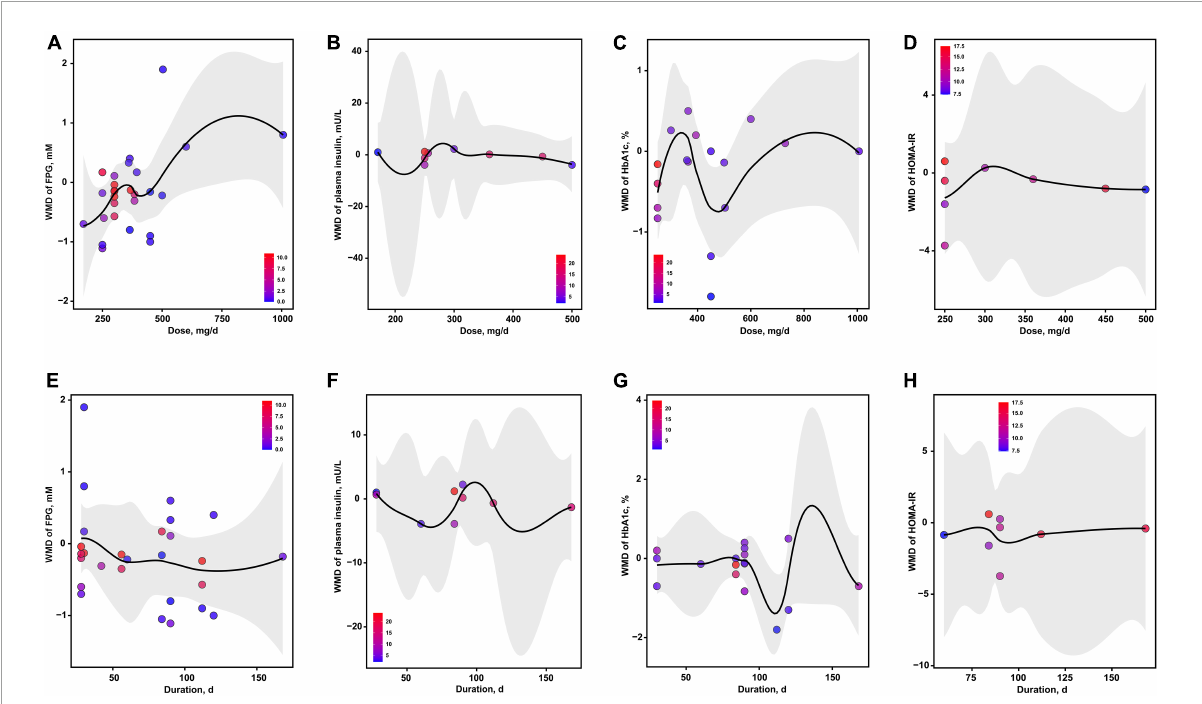
FIGURE5 The effects of dosage or duration of magnesium intervention on glycemic control for FPG (A,E) , insulin (B,F) , HbA1c (C,G) , and HOMA-IR (D,H) , respectively. FPG, fasting plasma glucose; HbA1c, glycated hemoglobin; HOMA-IR, homeostasis model assessment-insulin resistance.